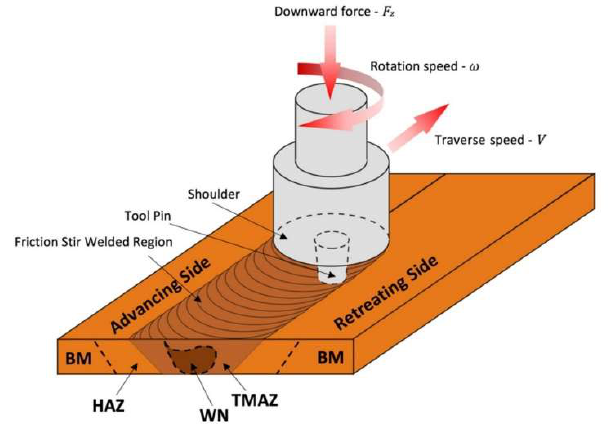
Figure 1. Schematic drawing of the friction stir welding (FSW) process.